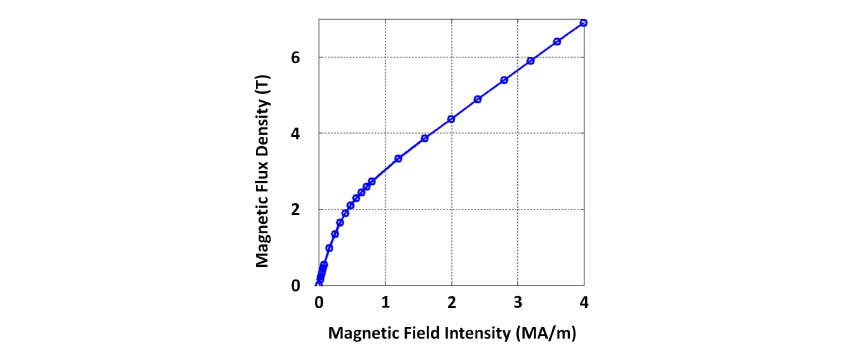
Figure 4. A measured magnetization curve of a specimen taken from a grey cast iron pipe segment.